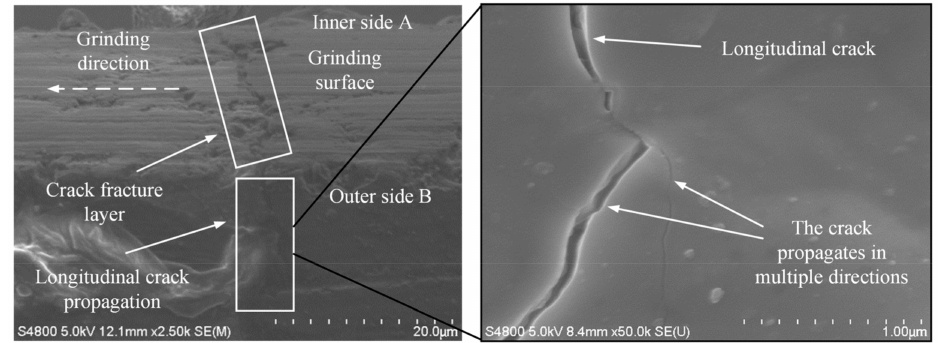
Figure 2. Details of crack propagation ( v s = 38 m/s, a p = 20 µ m, v w = 3500 mm/min).